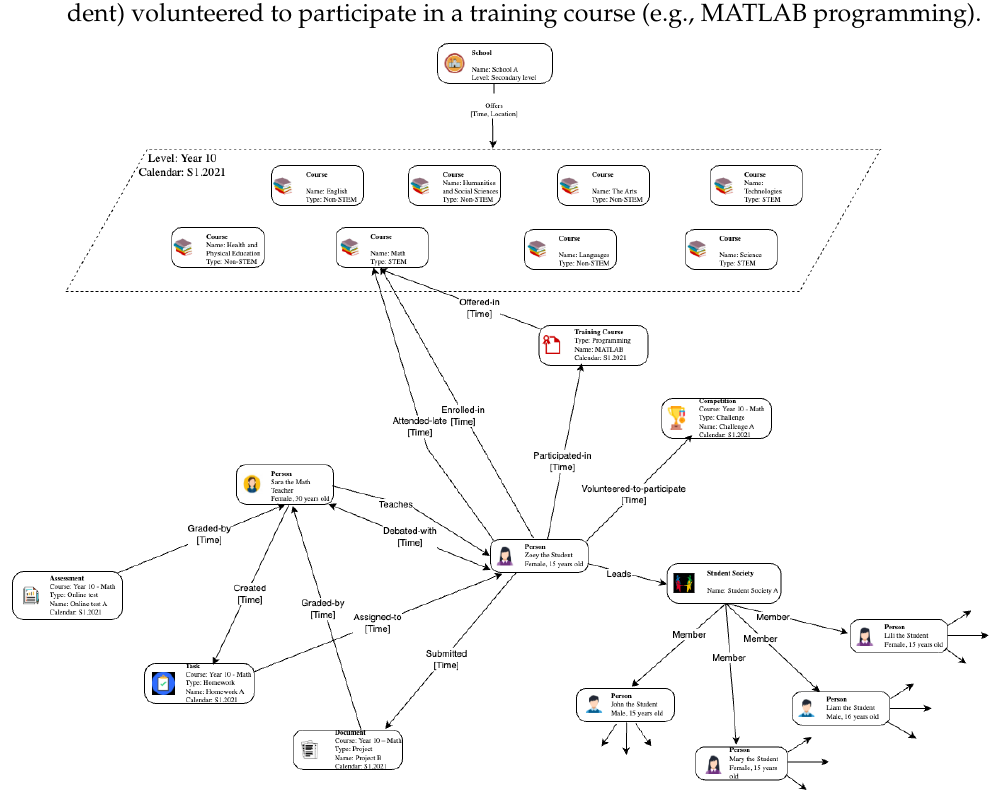
Figure 4. A canonical graph of the possible relationship between objects in an educational